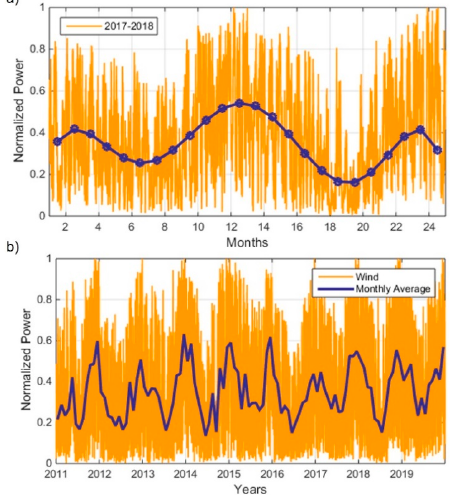
Figure 2. Profile of wind power generation in the UK: ( a ) in the period 2017–2018; ( b ) normalized historical data. Data from [25,27].